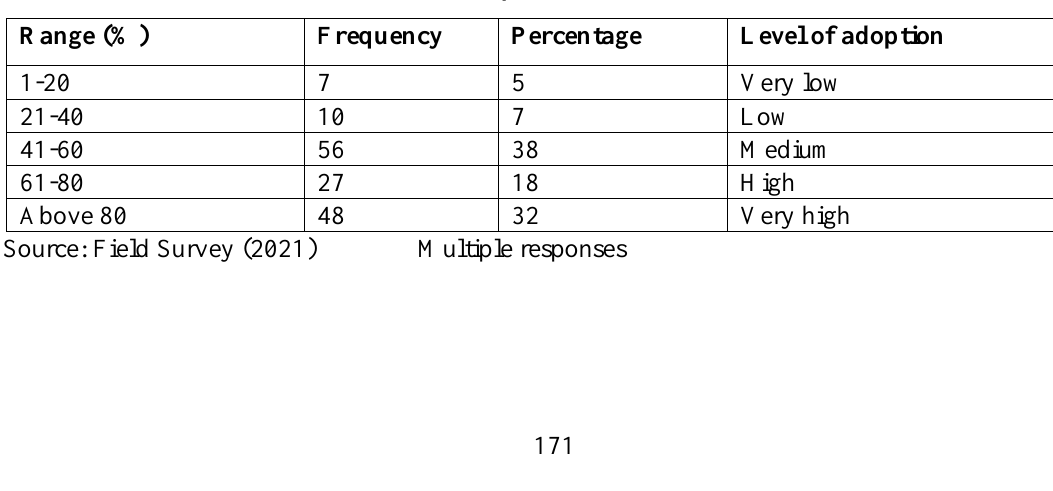
Table 4. Distribution of respondents on their level of adoption in agrochemical safety measure